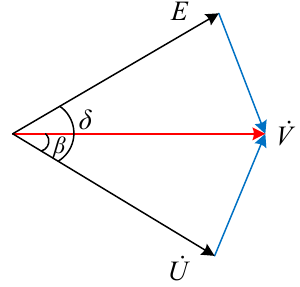
Figure 4. Voltage vector diagram of an equivalent system.